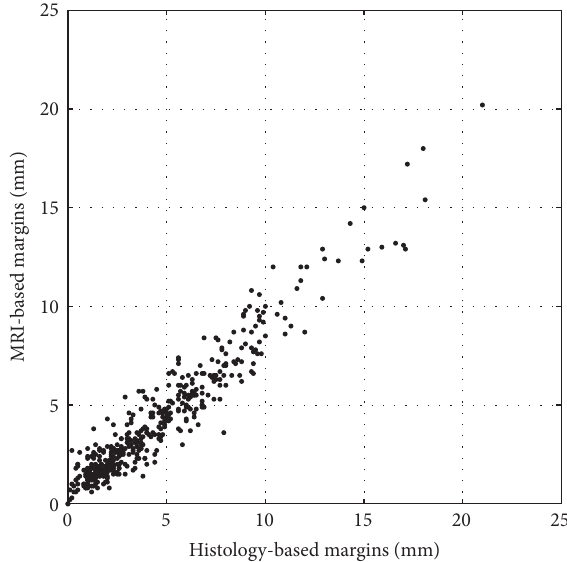
Figure 3: Correlation between the two measurement methods.